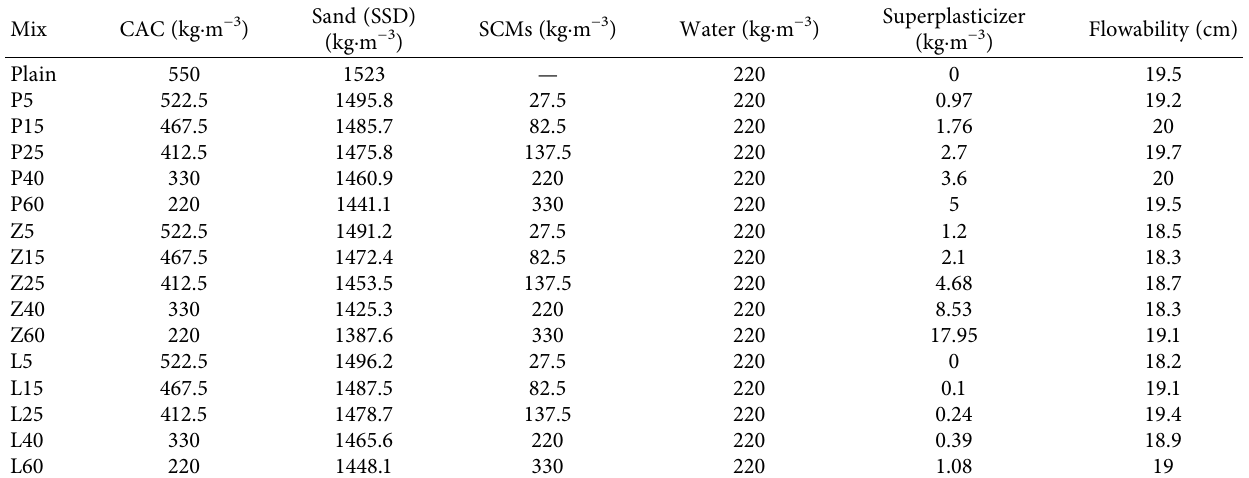
Table 4: Te mortar mixture